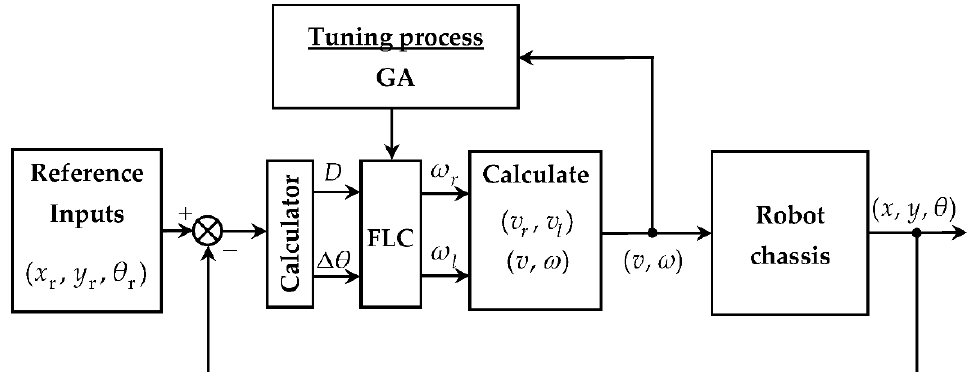
Figure 11. The optimization process of the fuzzy logic controller.